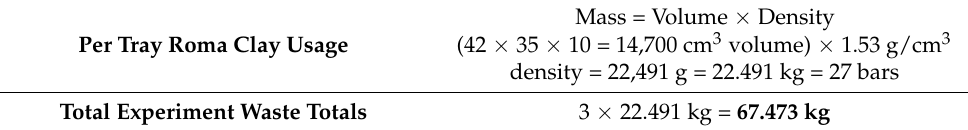
Table 4. Roma Plastilina No.1 Waste Generation from Survivability Assessment